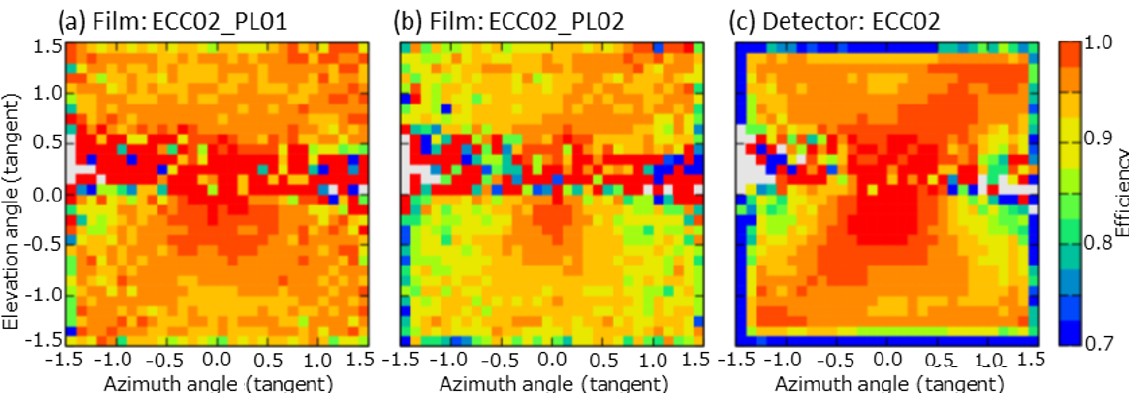
Figure 11. Examples of the angular distribution of the fill factor in some films and the efficiency of an ECC. (a) Fill factor for film ID = PL01 (most upstream film) and ECC ID = 02 at site N. (b) Fill factor for film ID = PL02 and ECC ID = 02. (c) Muon detection efficiency for ECC ID = 02 as evaluated by Eq. (4). The horizontal axis is the tangent of the azimuth angle; the vertical axis is the tangent of the elevation angle; the colors represent the fill factor/efficiency values. A positive elevation angle means the muon path is from the cone; a negative elevation angle means the muon path is from the backward free sky. The gray color means there were no observed muons in the angular bin due to the thick volcanic cone.